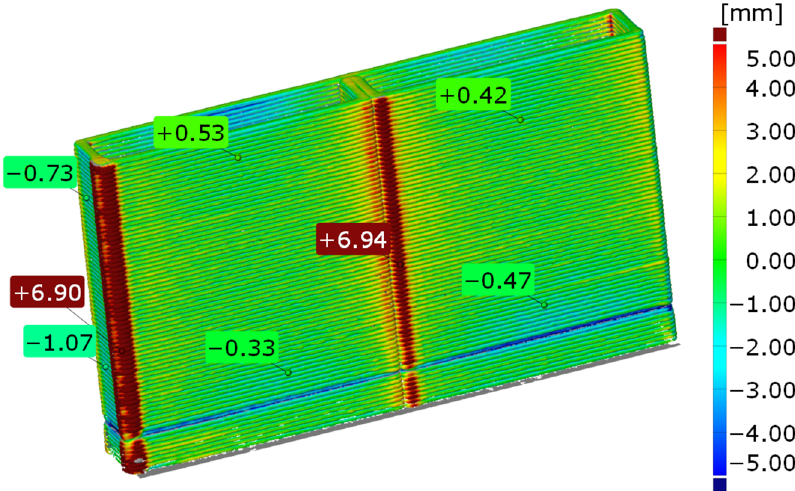
Figure 9. Color map showing deviations between printed and nominal model (28 ‐ day scan).